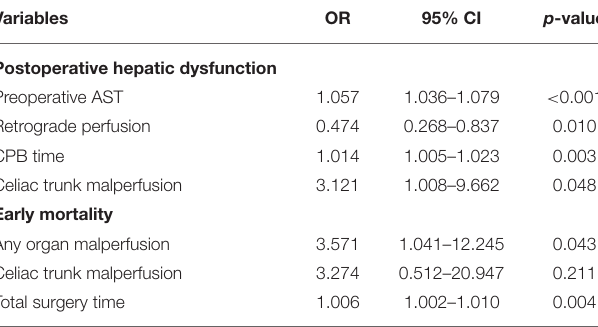
TABLE 3 | The multivariable mixed effect logistic regressions.